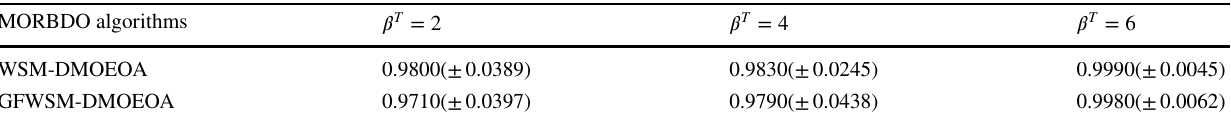
Table 12 The accuracy index Acc of the two MORBDO algorithms on the second MORBDO test example with different target reliability levels. Each result is in the form of mean ± standard deviation MORBDO algorithms